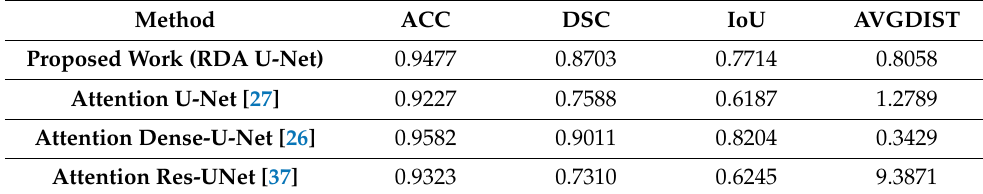
Table 3. Results of different models for evaluation lesion segmentation.